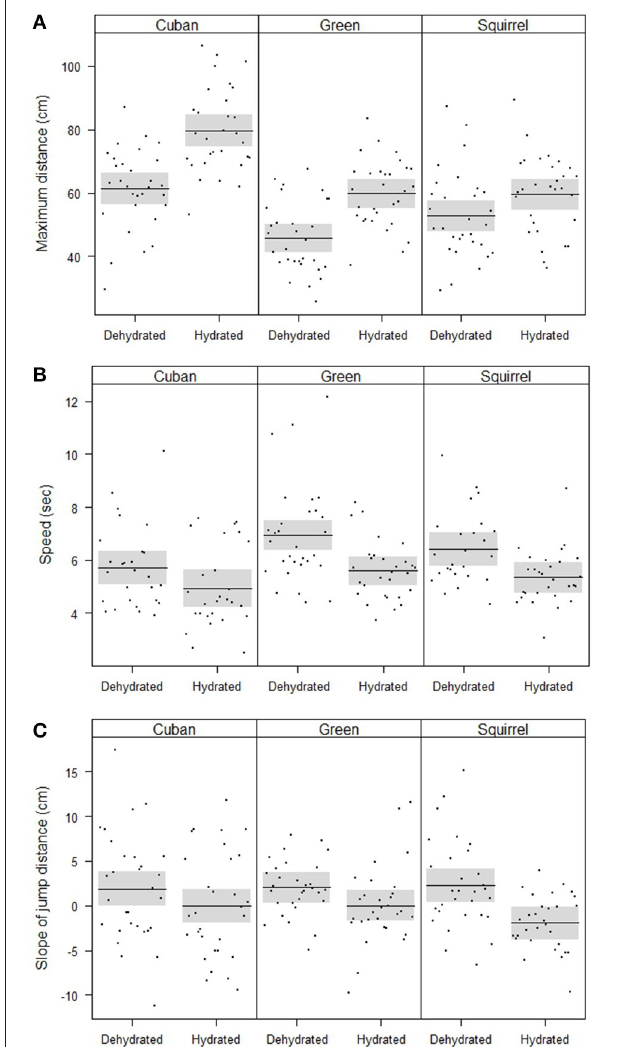
FIGURE 2 | Partial residual plots with means (lines) and 95% confidence bands (shaded), controlling for all factors in the statistical models that are not shown in the figures, showing the locomotor performance of frogs, including (A) the significant interaction between species and hydric state on the maximum jump distance, (B) significant effects of species and hydric state on speed, and (C) the significant effect of hydric state on the change in jump distance across five jumps (slope of jump distance vs. jump